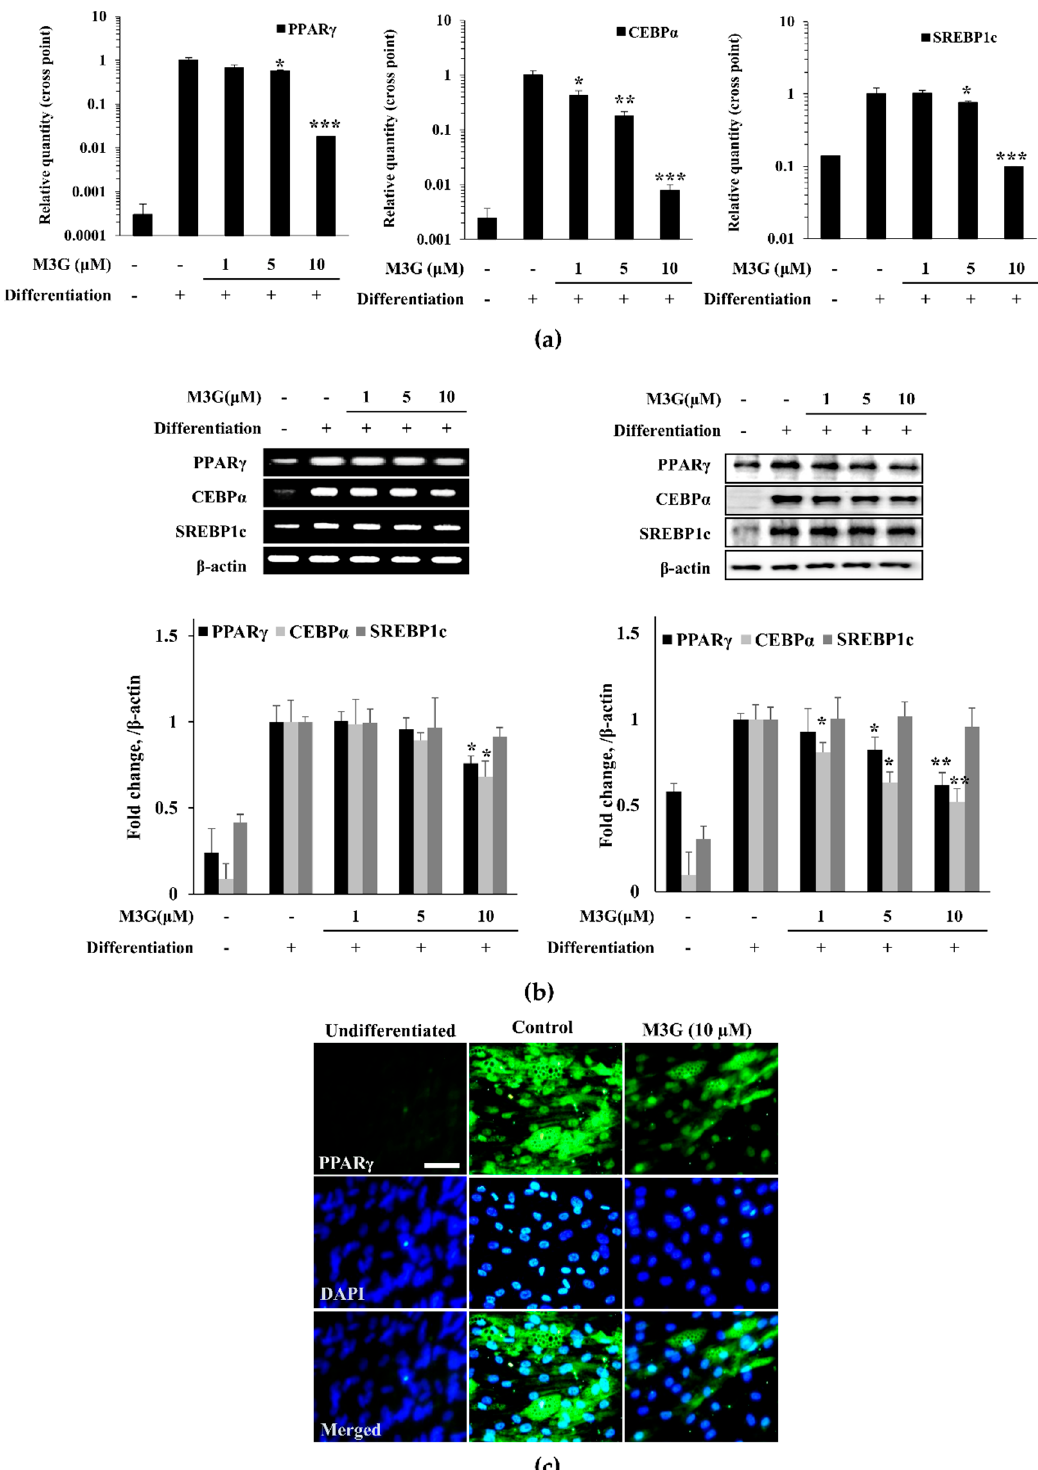
Figure 7. Effect of M3G on the expression of adipogenic marker genes ( a ) and proteins ( b ). Analysis of gene and protein expression of adipo-induced hBM-MSCs was carried out by RT-PCR and Western blot, respectively, at day 10 of differentiation. β -actin was used as internal loading controls. ( c ) Effect of M3G on the expression of PPAR γ in adipo-induced hBM-MSCs at day 10 differentiation analyzed by immunofluorescence staining. DAPI staining was used to highlight the nucleus of viable cells. Scale bar: 50 µ m. M3G was treated with initial differentiation for 3 days. * p < 0.05, ** p < 0.01, *** p < 0.001 vs. differentiated untreated